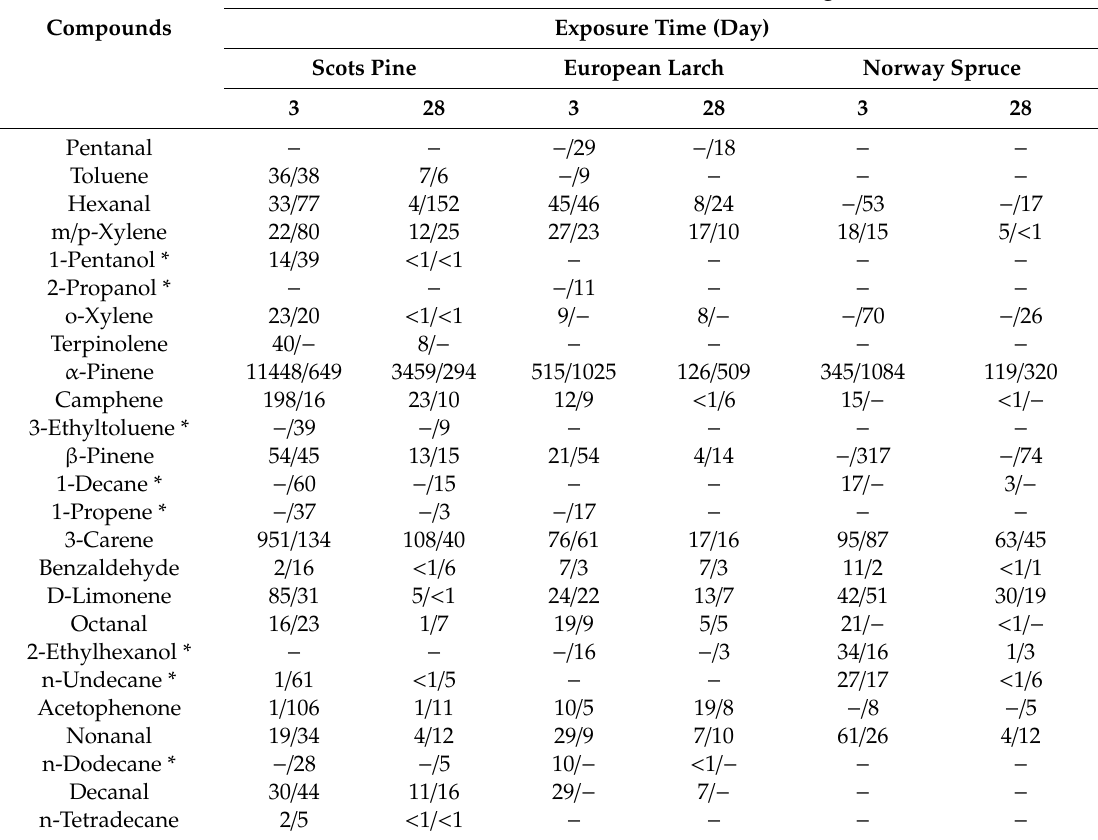
Table 1. Concentrations of volatile organic compounds emitted from heartwood and sapwood part of Scots pine, European larch and Norway spruce wood after 3 and 28 days of exposure of samples (values before a slash represent heartwood, while those after a slash represent